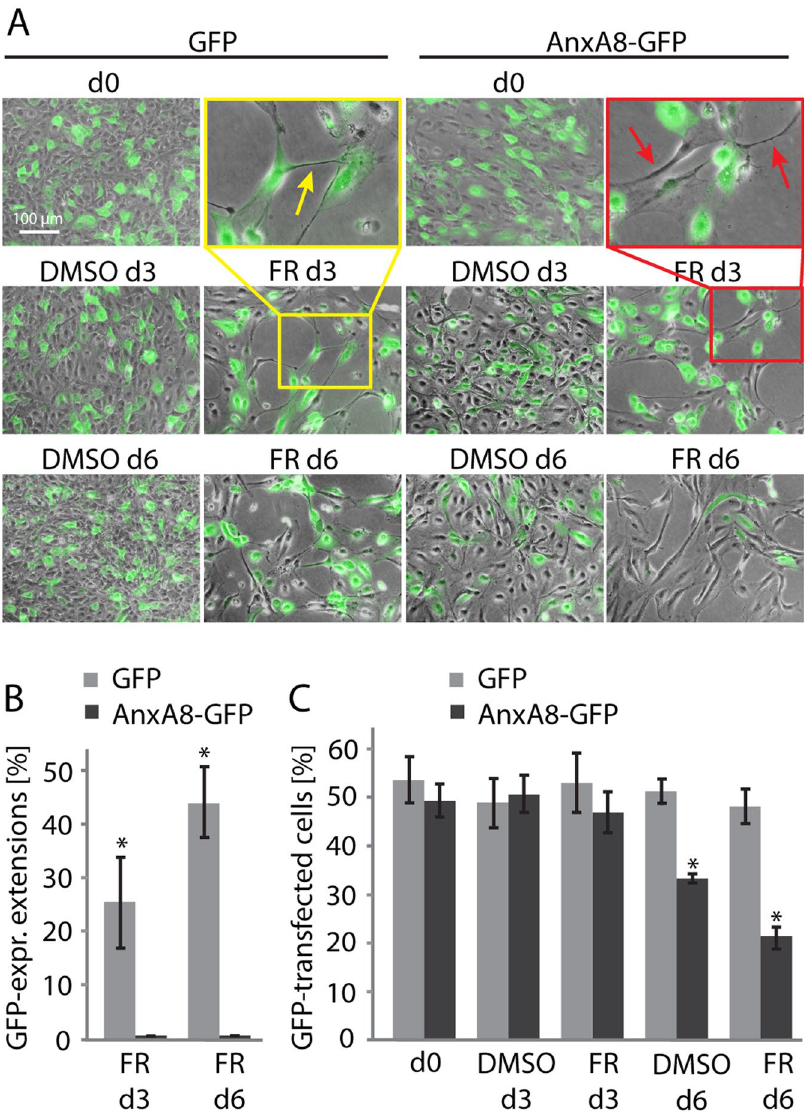
Figure 4. Ectopic expression of AnxA8 prevents FR-induced neuronal transdifferentiation. ( A ) Merged phase and fluorescence images of AnxA8-GFP- and GFP-transfected ARPE-19 cells, treated with either FR or the DMSO control for 0, 3 and 6 days. FR-induced transdifferentiation was observed in GFP-transfected (yellow arrow in inset) or non-transfected cells only (red arrows in inset). ( B ) Quantification of ARPE-19 cell extensions revealed 25% and 43% of GFP transfected extensions on day 3 and day 6 respectively of FR treatment, while AnxA8-GFP was never found in FR-induced cell extensions. Six representative images from four independent experiments were counted. ( C ) Quantification of the number of transfected cells at different stages of the experiment revealed that the initial transfection rate of the starting transfection rate of ~50% was maintained in GFP transfected cells after 6 days, whereas the proportion of AnxA8-GFP-transfected cells diminished to ~32% in DMSO and ~20% in FR. Data are mean and standard error of four independent experiments. For each experiment cells from 6 representative images were counted. Student’s t-test was used to calculate statistical significance ( * = P <